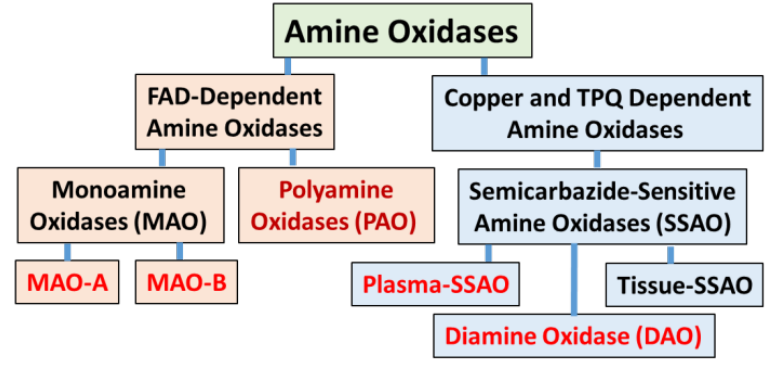
Figure 1. General classification of mammalian amine oxidases.